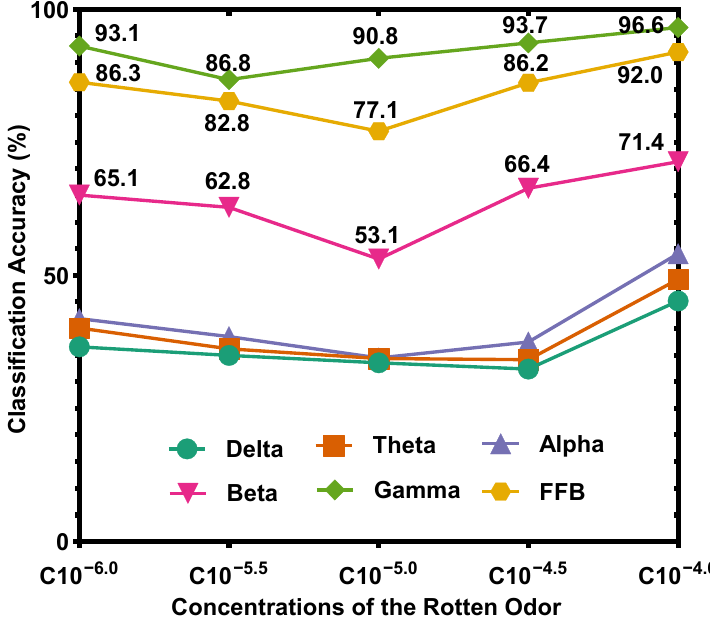
Figure 6. Average classification accuracy across 13 participants for five different rotten odor concentrations (using the SVM classifier).